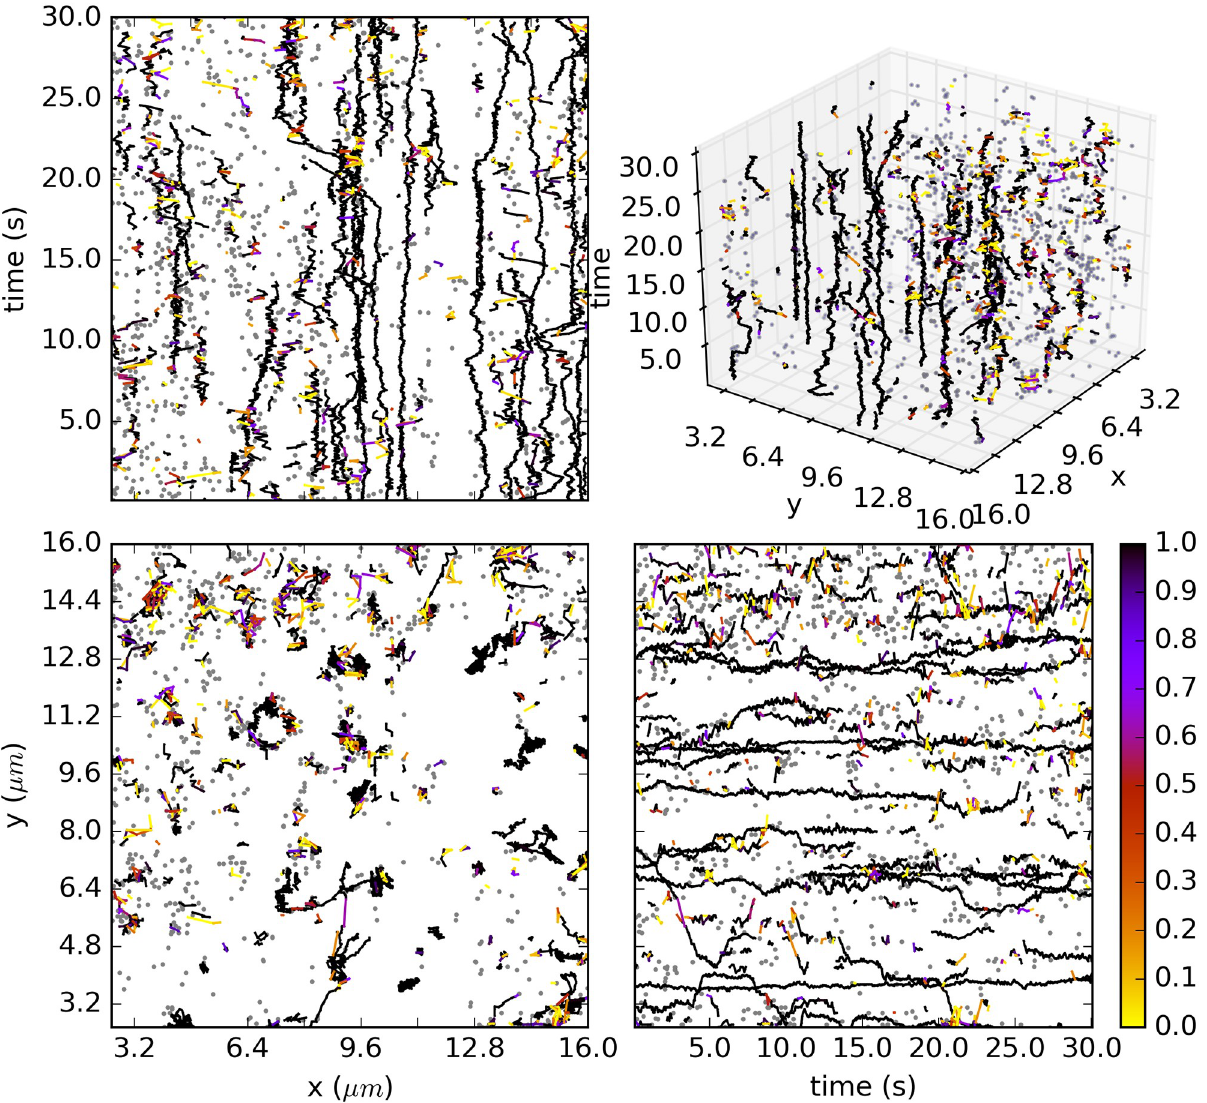
Fig 9. Two views on the tracking result for a SMM data set with 9761 observations. 4000 samples have been recorded. Links that appear in all samples are shown in blue. The colour of the other links indicates their frequency of occurrence as shown by the colour bar. Observations that are assigned to the clutter in all samples are shown as grey